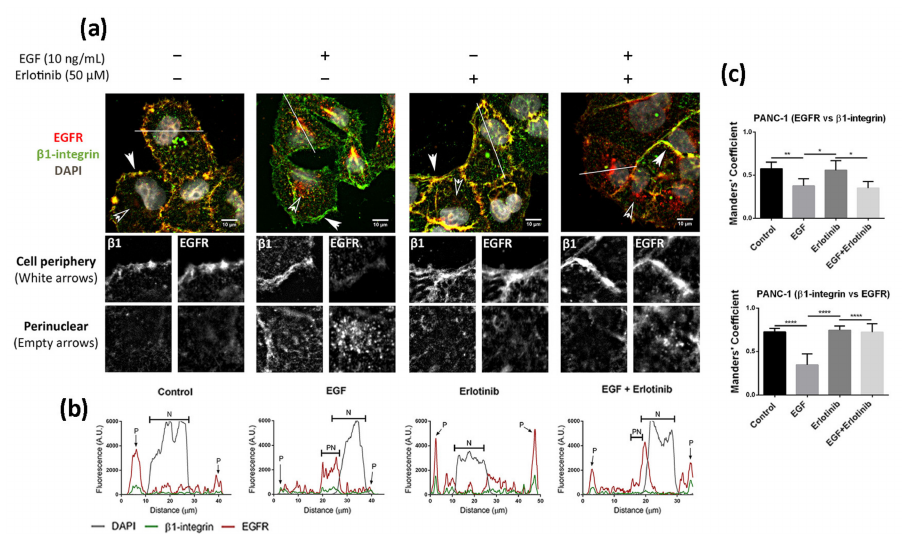
Figure 3. Immunofluorescence analysis of the EGFR in PANC-1 cells incubated with EGF, erlotinib or both in 2D cultures. ( a ) EGFR (red) and β 1-integrin (green) immunofluorescence counterstained with DAPI (grey) in the presence of EGF, erlotinib or both in PANC-1 and close-up sections (gray pictures) of the cell periphery and the perinuclear area labeled with white and empty arrows, respectively. Scale bars represent 10 µ m; ( b ) fluorescence intensity profiles corresponding to the white line in pictures from ( a ). Different cell regions are indicated as P for cell periphery, N for nucleus and PN for perinuclear area; ( c ) Manders’ colocalization coefficients. Statistical differences are indicated as * for p < 0.05, ** for p < 0.01 and **** for p <